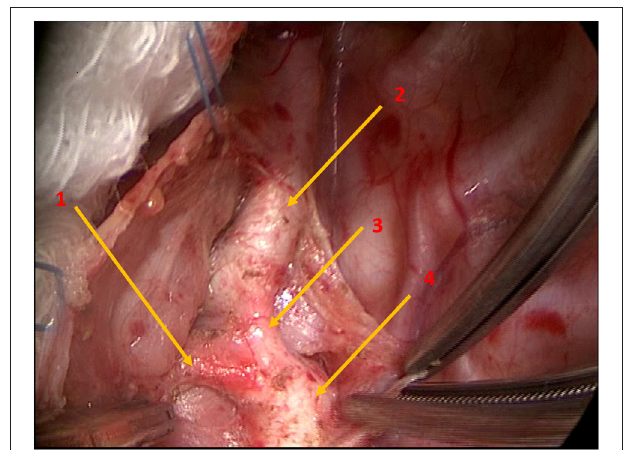
FIGURE 1 | Intraoperative photograph demonstrating the anatomy of the left arch at surgery, including the transverse lie of the proximal left arch along with the origin of the left subclavian artery. Arrow 1: Ductal ligament; Arrow 2: Left subclavian artery; Arrow 3: Left aortic arch; Arrow 4: Descending thoracic